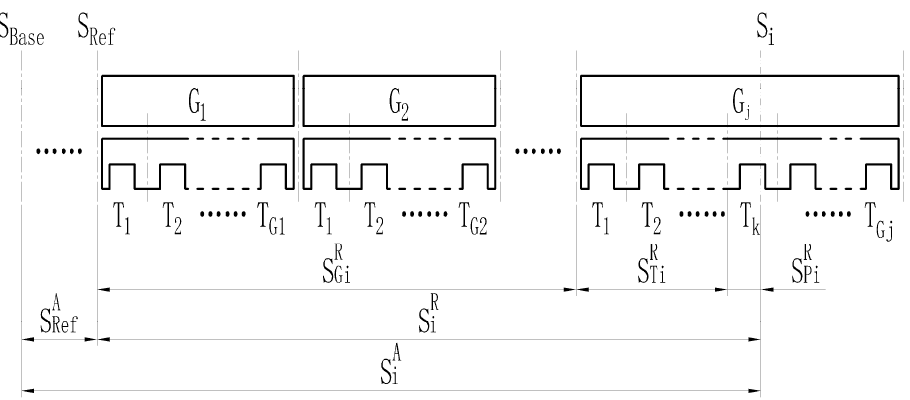
Figure 6. Schematic diagram of locating principle.